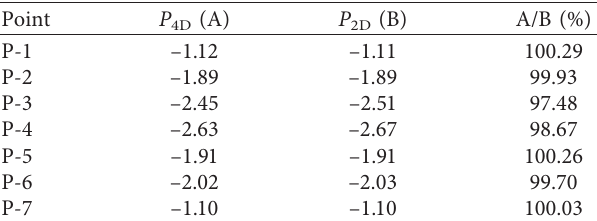
Table 8: Minimum principal stress of midwall monitoring points